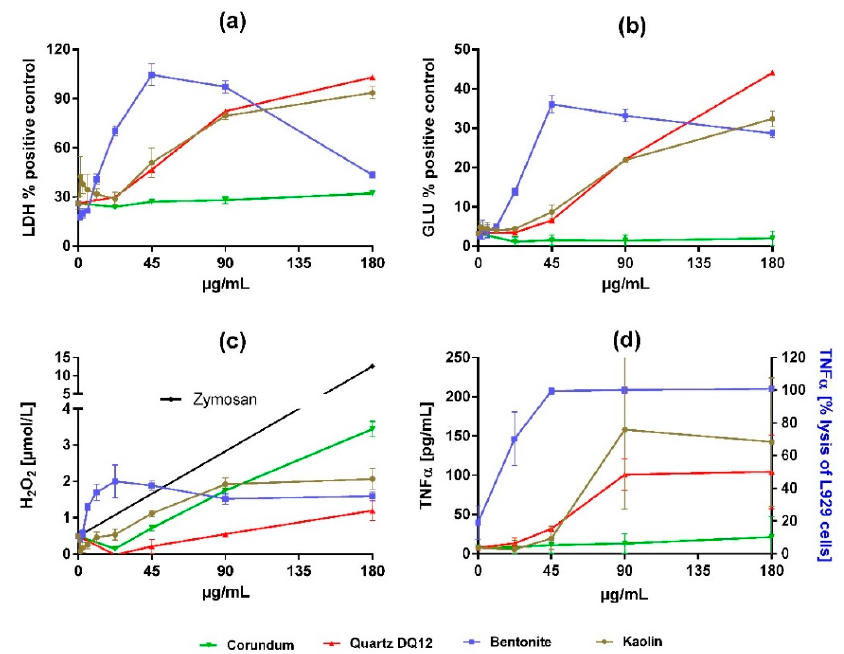
Figure 3. Dose-dependent e ff ects of corundum, quartz DQ12, bentonite, and kaolin on NR8383 alveolar macrophages in vitro. Cultures of 3 × 10 5 cells per well were incubated with particle concentrations, as indicated by the graphs. After 16 h, culture supernatants were assessed for ( a ) activity of lactate dehydrogenase (LDH) in percent of triton X-100 lysed control cells, ( b ) activity of glucuronidase (GLU) in percent of triton X-100 lysed control cells, ( c ) extracellular H 2 O 2 , and ( d ) tumor necrosis factor α (TNF α ), measured by a specific enzyme-linked immunosorbent assay or, in the case of bentonite, by the lysis of L929 fibroblasts. The black line in (c) shows H 2 O 2 release upon 180 µ g / mL zymosan (positive control). Values are means ± SD from three independent experiments. Table 2. In vitro e ff ects of corundum, quartz DQ12, kaolin, and bentonite on NR8383 macrophages. Material